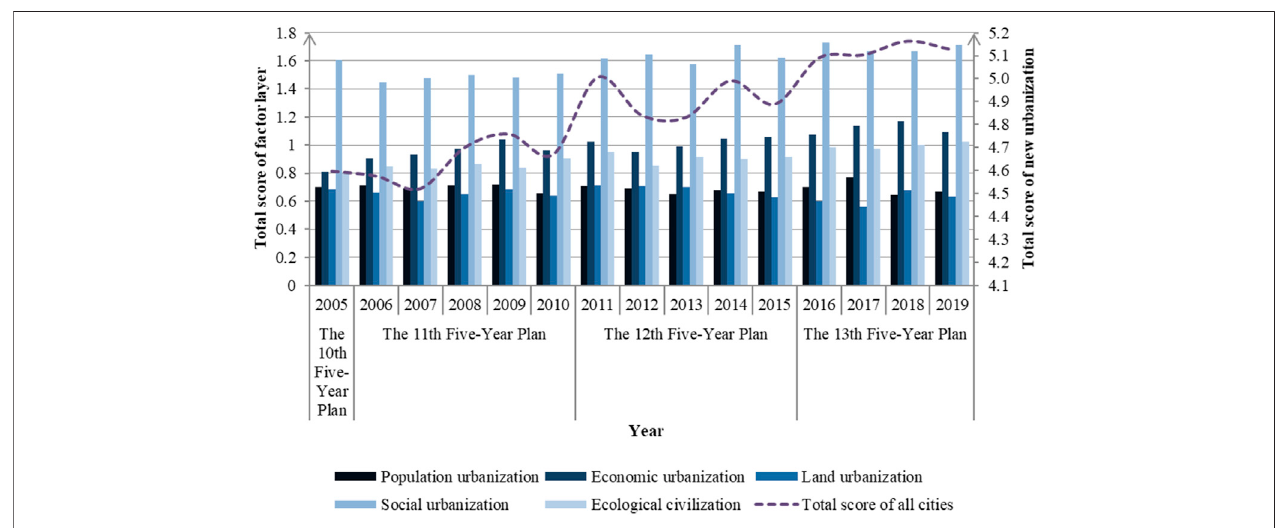
FIGURE 4 | Total scores of new urbanization and factor layers in western provincial capitals from 2005 to